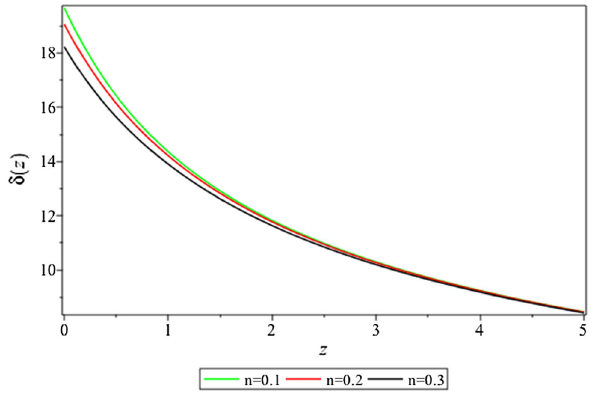
Fig. 8 The growth of the density contrast versus cosmological redshift for the generalized f ( T ) model for the system of Eqs. (133)–(138) for n > 0, ˜ Ω m = 0 . 32 and k = 10